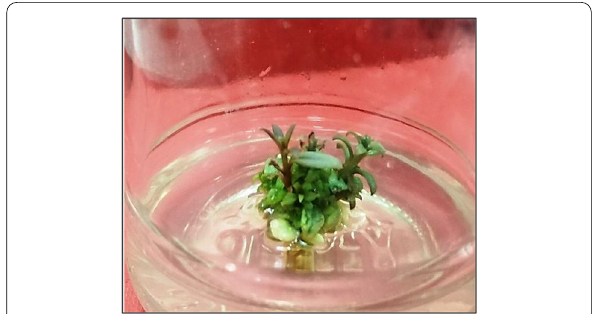
Fig. 1 Shoot tip of L. barbarum cultured on MS medium